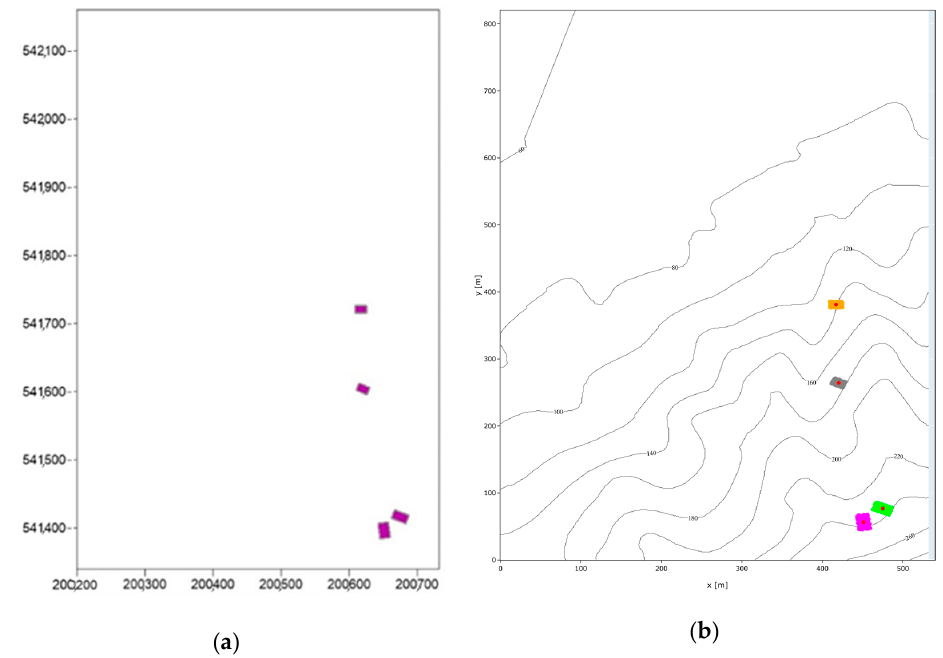
Figure 13. Comparison of results from ( a ) the initial landslide source [16] and ( b ) the k-means clustering algorithm and the Elbow method against the initial landslide region. The different debris-flow clusters are represented in different colors. The red dots indicate the centroid of each cluster.